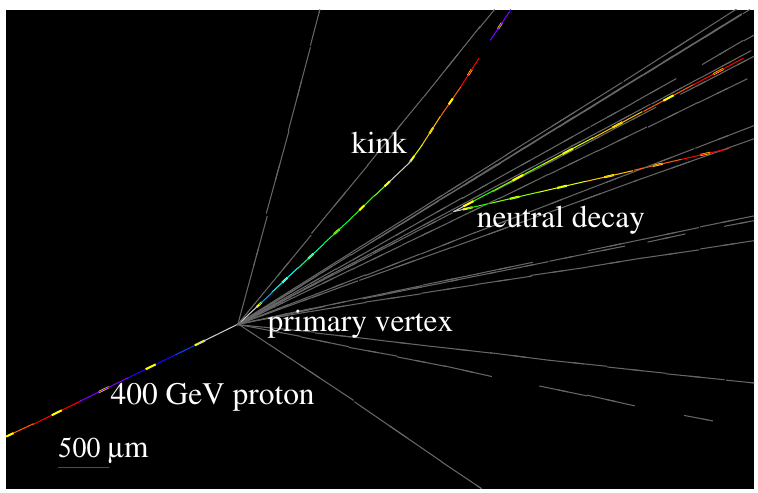
Figure 20 . A double charm candidate event with a neutral 2-prong (vee) and a charged 1-prong (kink) topology (tilted view). See the text about the detail of event